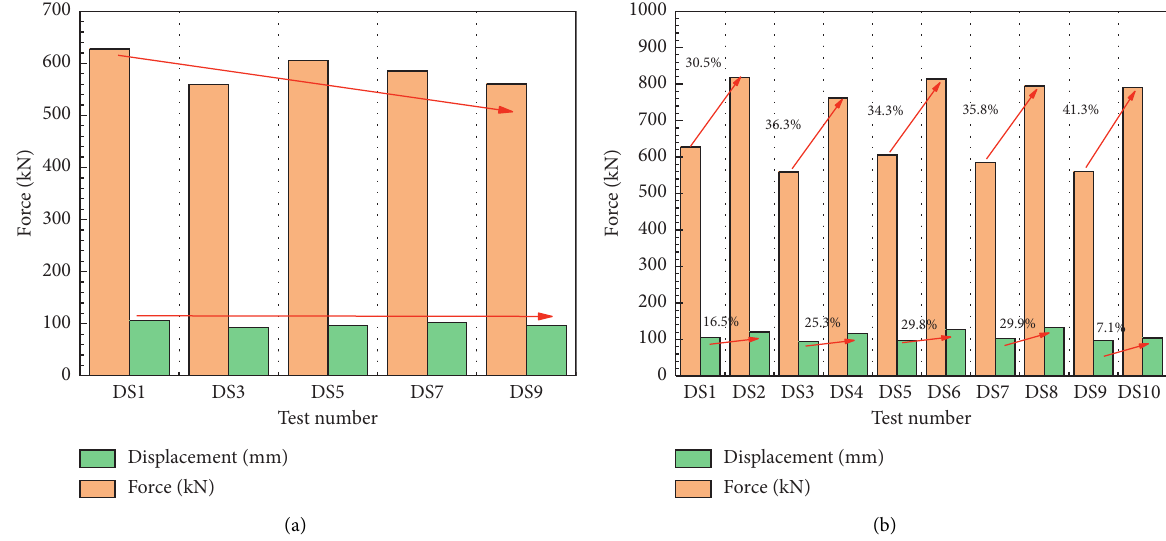
Figure 6: Comparison of shear bearing capacity of supporting materials. (a) Analysis of shear bearing capacity of the anchor cables with the diameter of 21.6mm. (b) Comparison of bearing capacity between anchor cables with the diameter of 21.6mm and the same type of